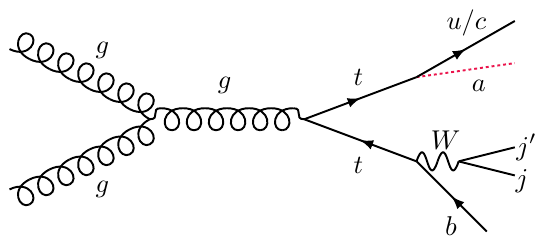
Figure 3 . The Feynman diagram for the signal: t ¯ t production, where one of the tops decay to q = u, c and an